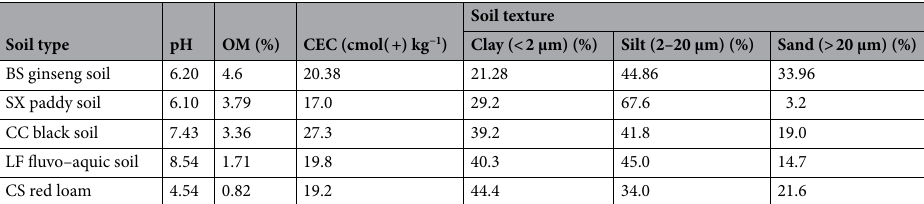
Table 1. Physical and chemical properties of the five tested soil types.